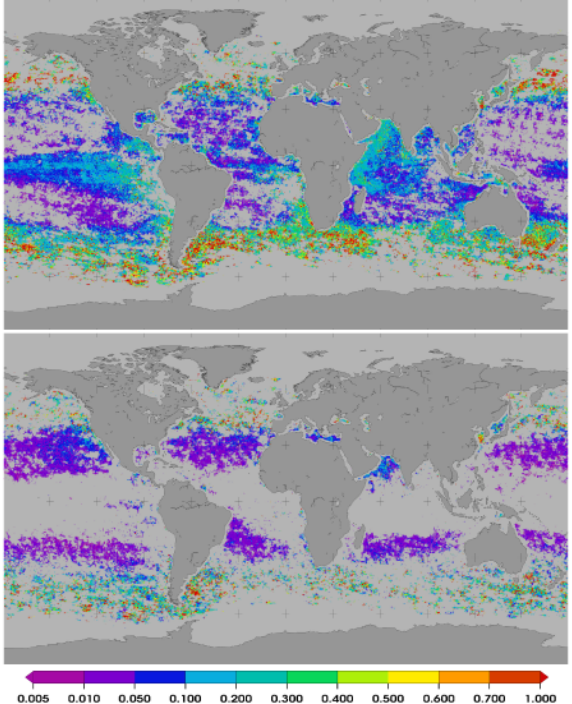
Fig. 5. Global distribution of chl a [mgm − 3 ] for coccolithophores (upper panel) and dinoflagellates (lower panel), retrieved via PhytoDOAS method in the triple-target mode from SCIAMACHY data; monthly averages over March 2005.